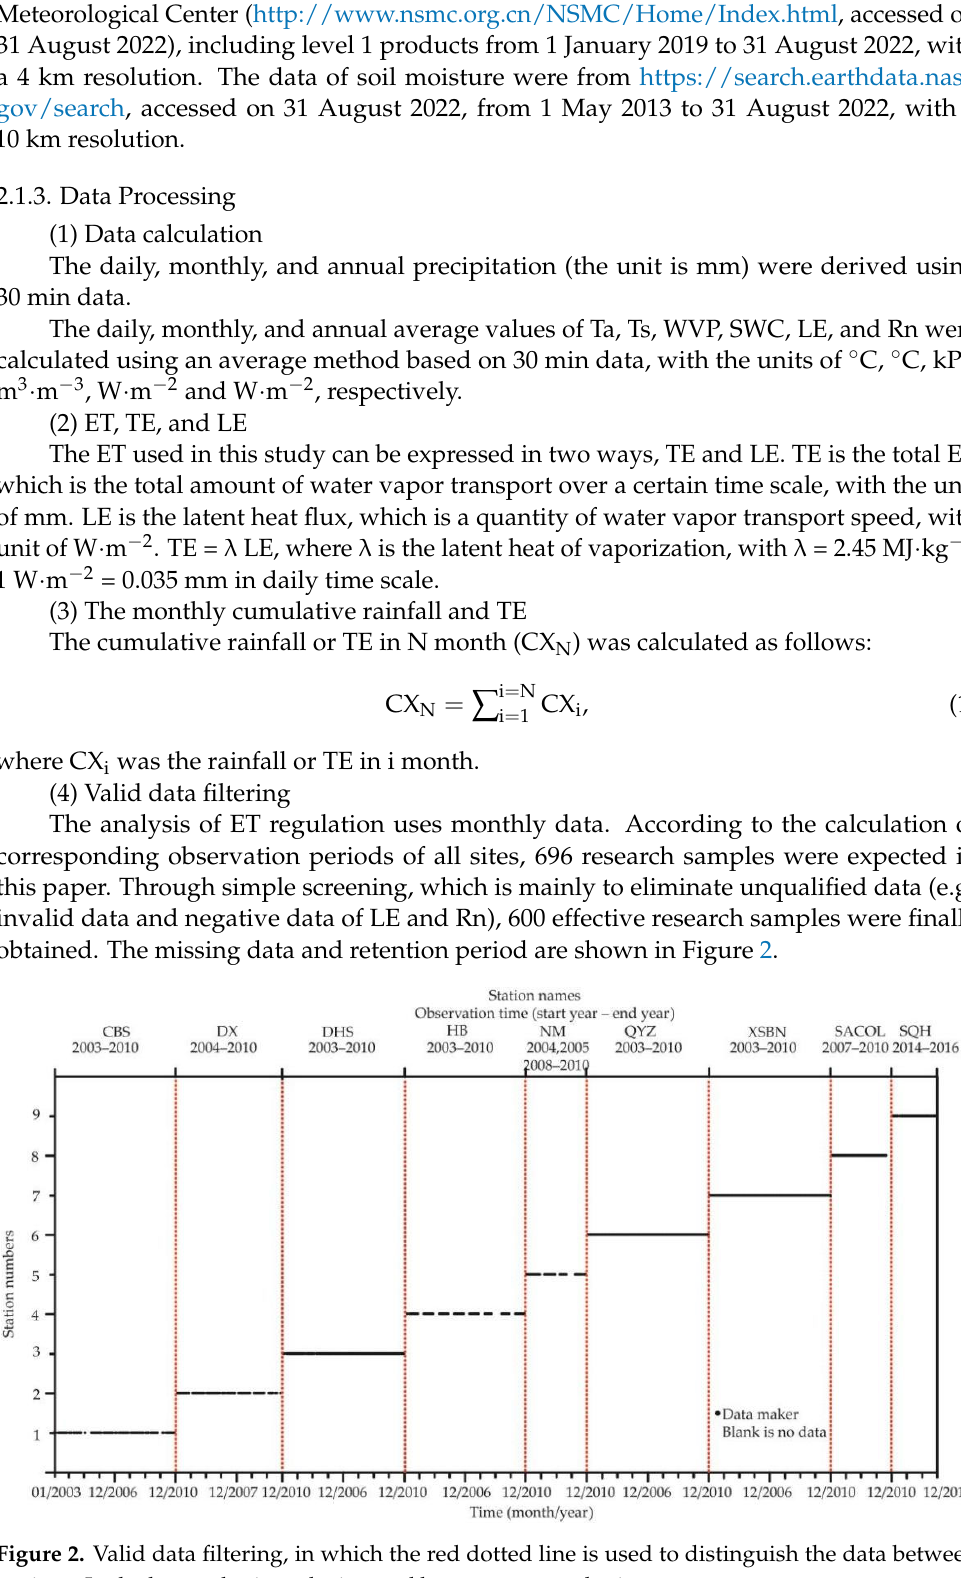
(c) Figure 3. Correlation analysis of the ET to Rn ratio (ET/Rn) and normalized difference vegetation index (NDVI) ( a ), mean land surface temperature (LSTm) ( b ), and the range of LST difference (DLSTR) ( c ).